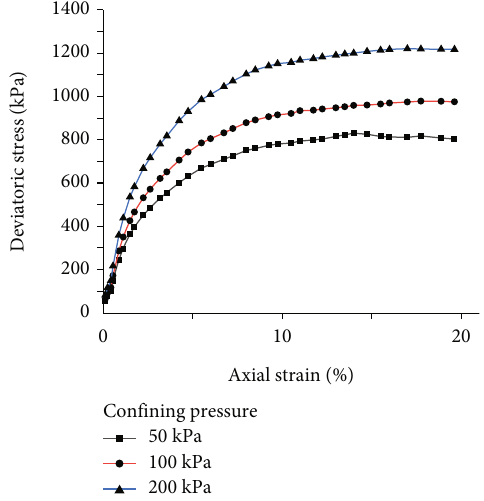
Figure 6: Deviatoric stress-axial strains of solidi fi ed soil samples with 1.0mol/L calcium gluconate solidi fi ed under con fi ning pressures.